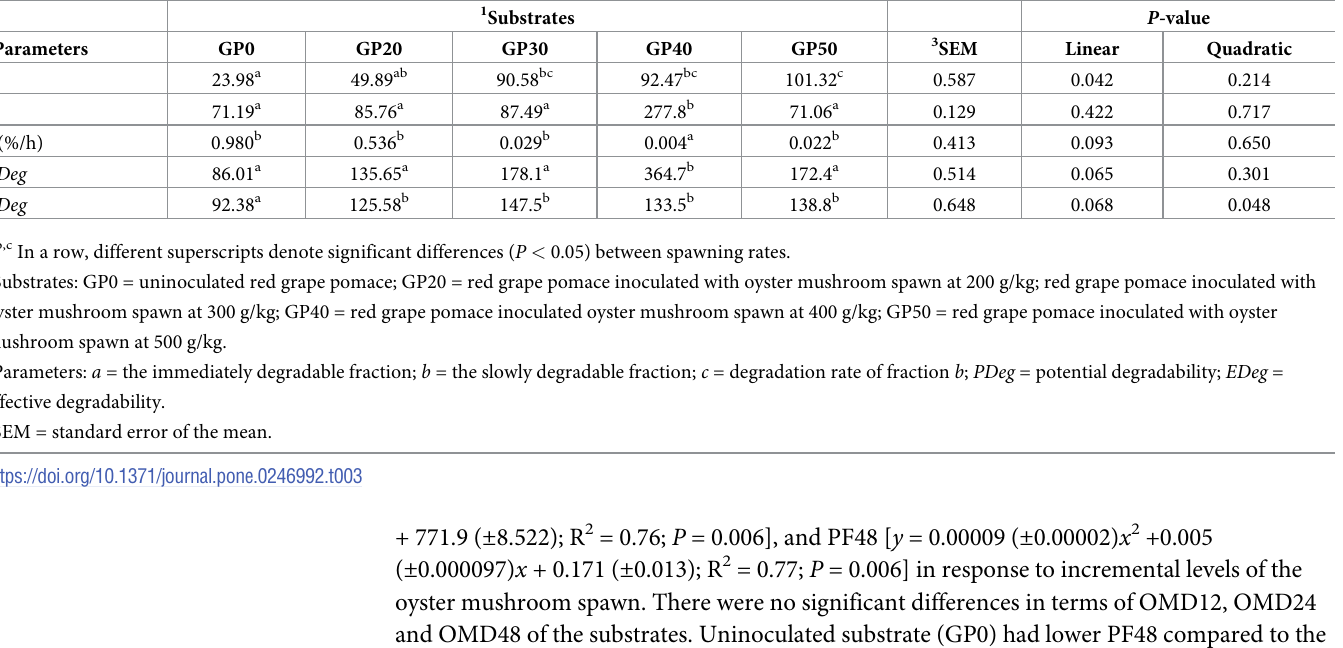
Table 3. In vitro ruminal dry matter degradability (g/kg DM) of red grape pomace spent oyster mushroom substrate.